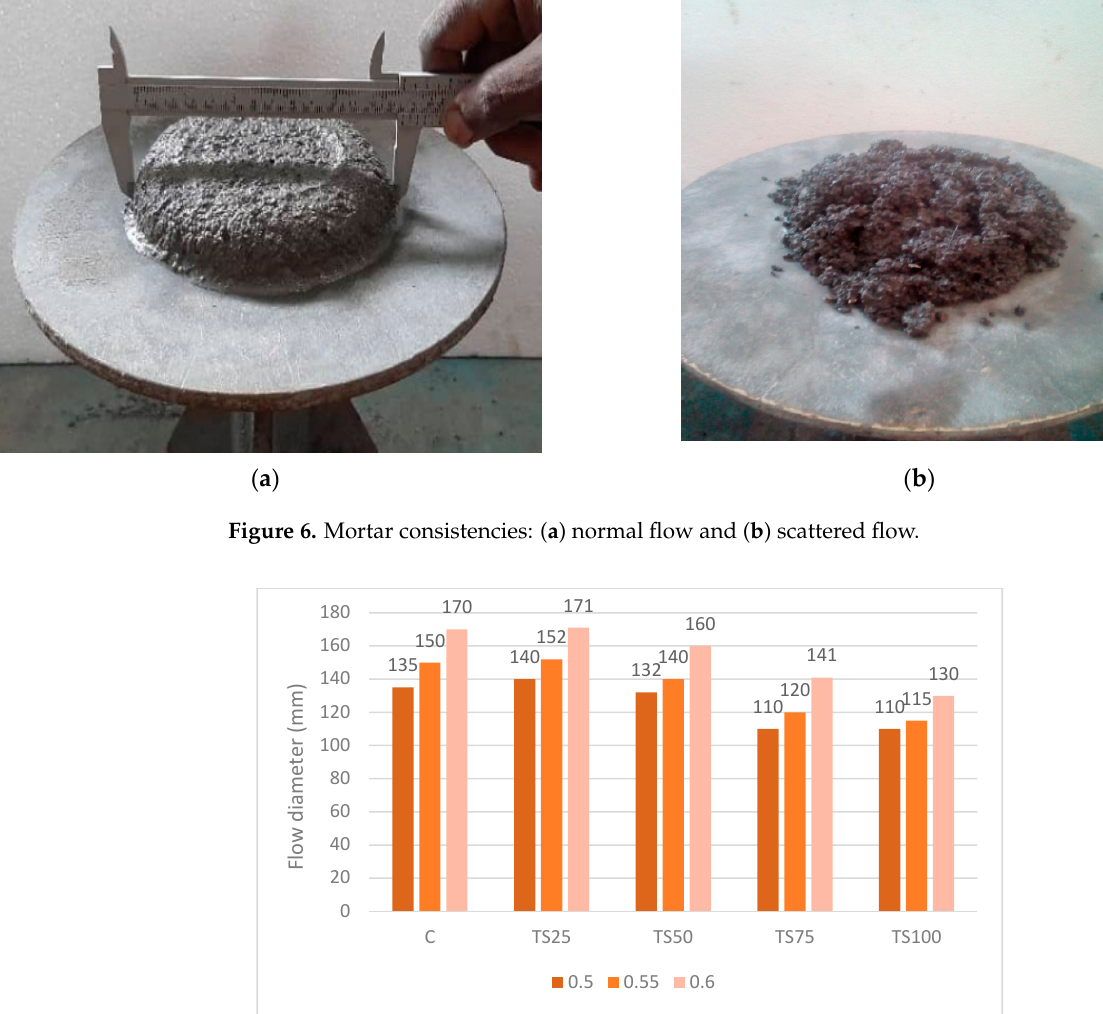
Figure 7. Flow diameters of ungraded TS at different w / c ratios.